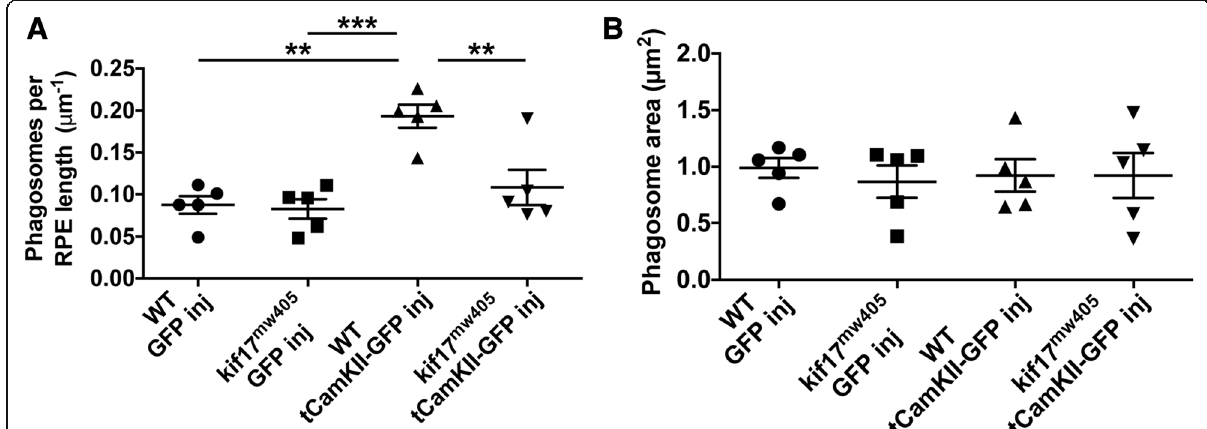
Fig. 6 CaMKII promotes kif17 -dependent disc shedding. a TEM phagosome number analysis of 7 dpf GFP-positive wild-type and kif17 mw405 larvae injected with either control TaCP:GFP ( n = 5 injected larvae, 843 μ m of RPE for WT; n = 5, 795 μ m of RPE for kif17 mw405 ) or the constitutively active CaMKII construct TaCP:tCaMKII-GFP ( n = 5, 1011 μ m of RPE for WT; n = 5, 1322 μ m of RPE for kif17 mw405 ). b Quantification of the size of phagosomes for wild-type and kif17 mw405 larvae injected with either TaCP:GFP ( n = 5 injected larvae, 74 phagosomes for WT; n = 5, 70 phagosomes for kif17 mw405 ) or TaCP:tCaMKII-GFP ( n = 5, 193 phagosomes for WT; n = 5, 141 phagosomes for kif17 mw405